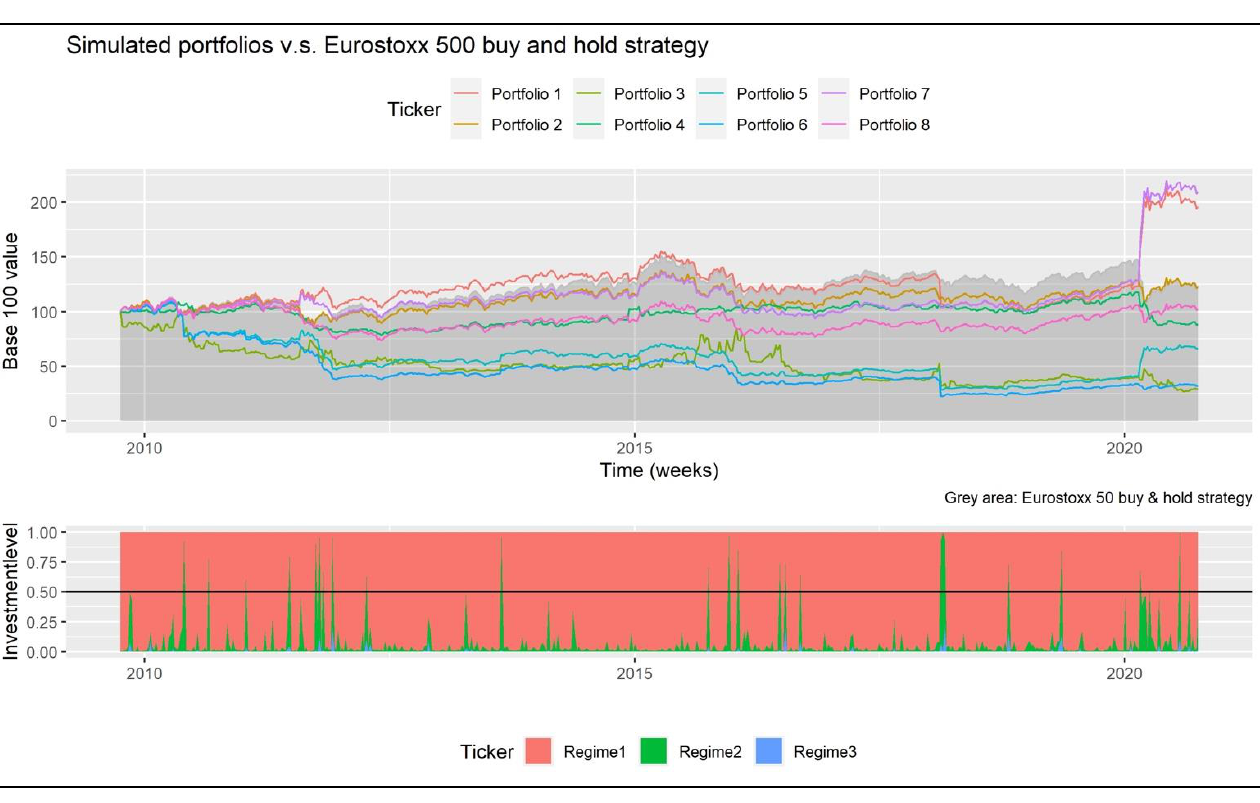
Figure 3. Weekly historical performance of the eight simulated portfolios of Table 2 with smoothed ( ω i = ξ s = i , T + 1 ) weighting method. It presents the historical 9 July 2009 Base 100 value of the eight simulated portfolios (lines) against a buy-and-hold ESTOXX50 strategy (grey area). The historical three-regime MS-GARCH regime-specific forecasted smoothed probabilities ( ξ s = i , T + 1, t ). Methodological note: The eight simulated portfolios do not include the impact of stock trading fees.